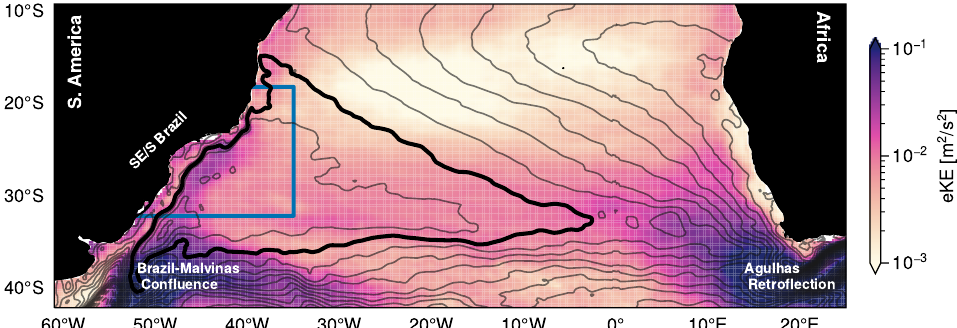
Figure 1. The surface circulation and variability of the subtropical South Atlantic as depicted by the CNES-CLS18 mean dynamic topography (MDT) contoured every 0.05 m (black lines) and the surface eddy kinetic energy from 28 years of satellite altimetry (colors). The thick black line is the longest closed contour of MDT = 0.60 m, one of the outermost closed contours of the South Atlantic Subtropical Gyre and a good proxy for the time-mean Brazil Current front off Southeast and South Brazil. The blue lines define the regional focus area of this